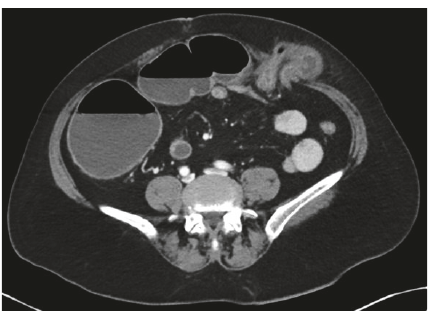
Figure 1: Axial CT showing incisional hernia in the left lower quad- rant containing transverse colon causing large bowel obstruction.